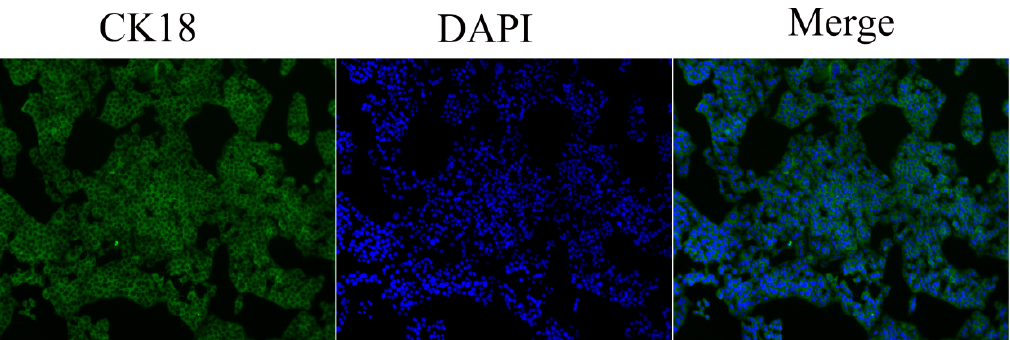
Figure 5. Immunofluorescence staining of cytokeratin 18 and the authentication of primary endo- metrial epithelial cells cultured in vitro. CK18 is fluorescent staining for cytokeratin 18. DAPI is fluorescent staining of the nucleus. Merge is CK18 staining and nucleus staining. Original magnifi- cation, 100×.